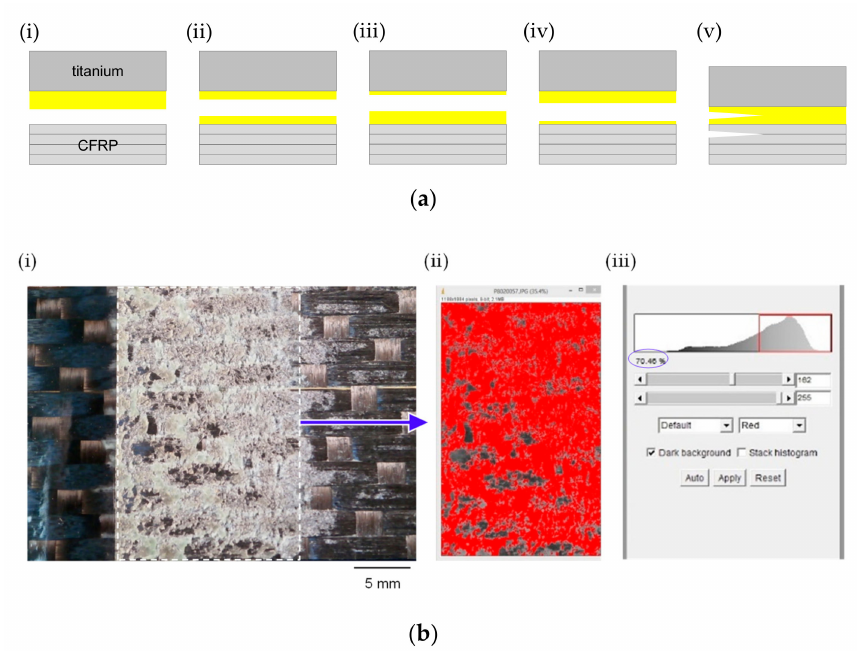
Figure 4. ( a ) Classification of the failure modes of interest in the present study (the sketches are not in scale): (i) FM1, adhesive failure; (ii) FM2, cohesive failure; (iii) FM3, thin-layer cohesive failure, titanium side; (iv) FM4, thin-layer cohesive failure, CFRP side; and (v) FM5, adherent failure. ( b ) The method followed to deduce the fracture mode percentages. (i) Photograph of the fracture surface under examination. (ii) Processing the photograph using the ImageJ software. (iii) Color scale-based determination of the failure mode